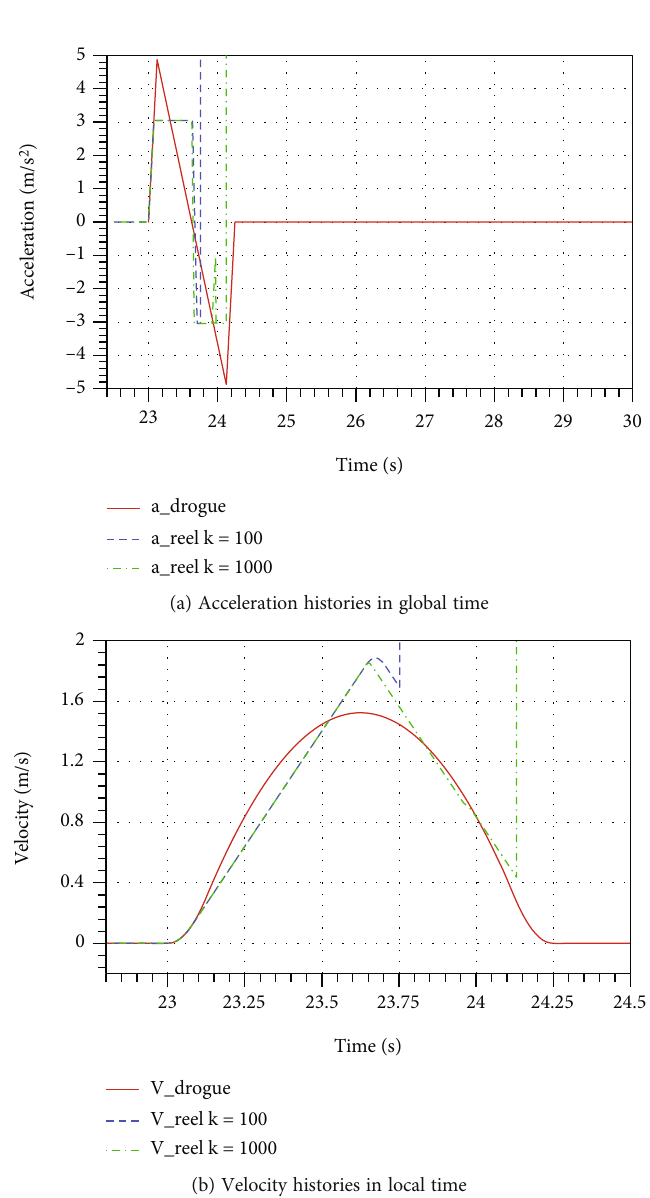
Figure 12: Case W4aE0-k velocity and acceleration histories with di ff erent k